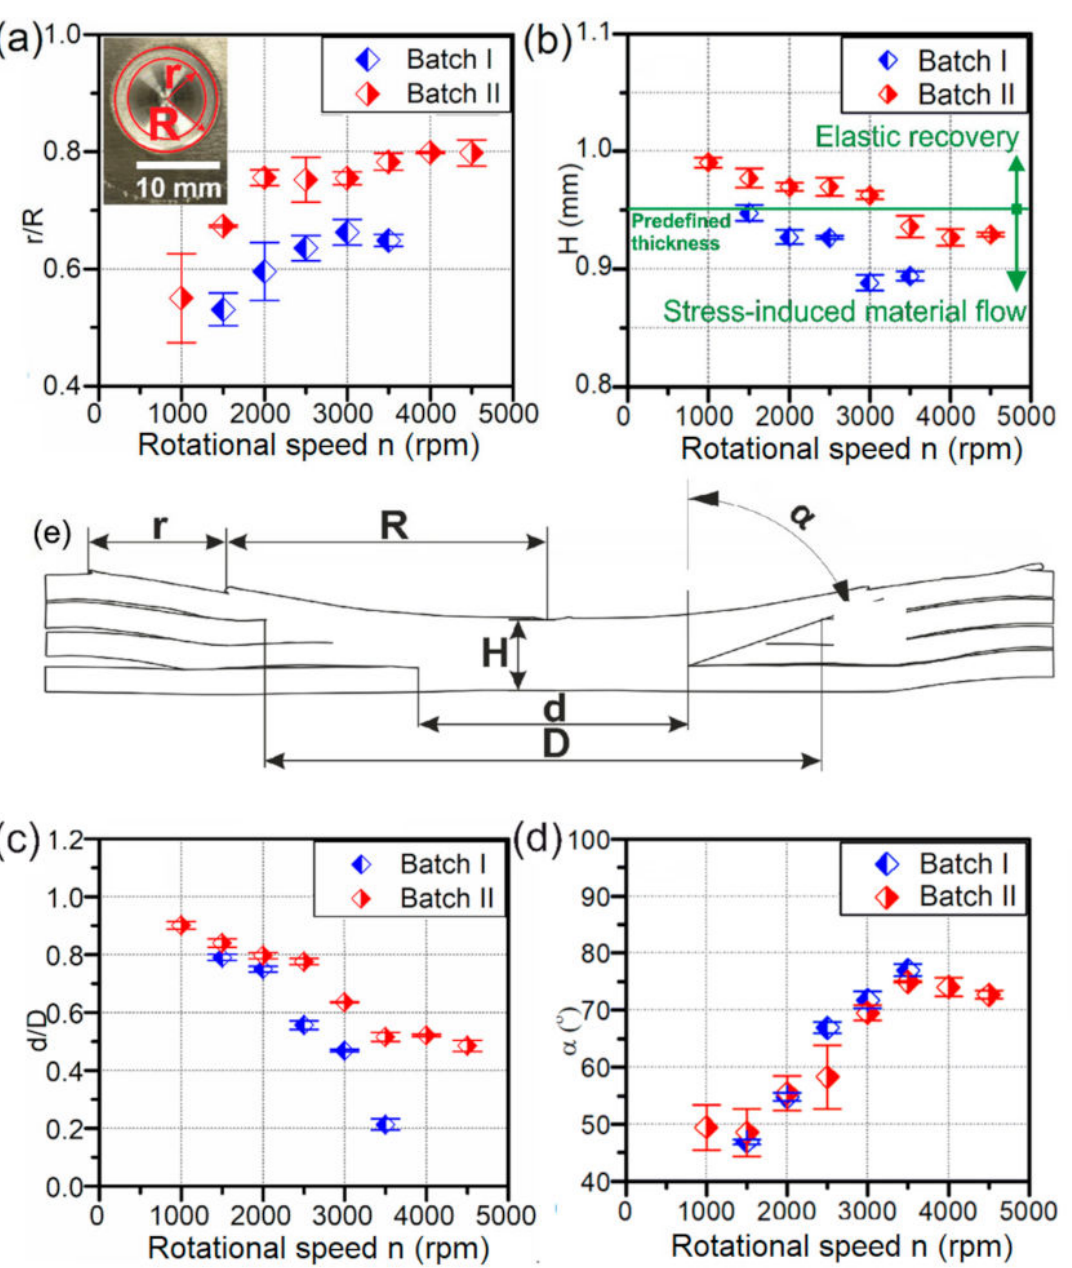
Figure 6. Dimensional quantification of the weld as a function of the rotational speed of the tool: ( a ) ratio of the radius of the edge-chipping area and stable process-pressure area-r/R; ( b ) axial thickness of the weld-H ( c ) ratio of the bottom diameter of the stir zone and top diameter of the stir zone-d/D; ( d ) trapper angle of the stir zone- α ; ( e ) schematic of the